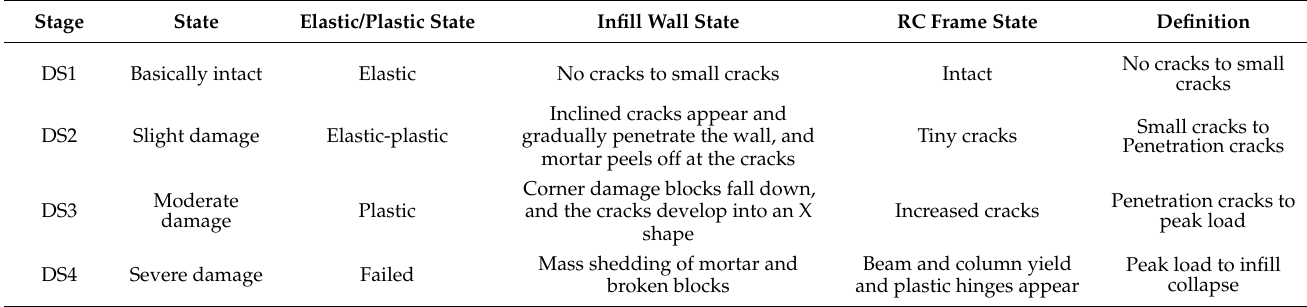
Table 3. Definition of DSs in this